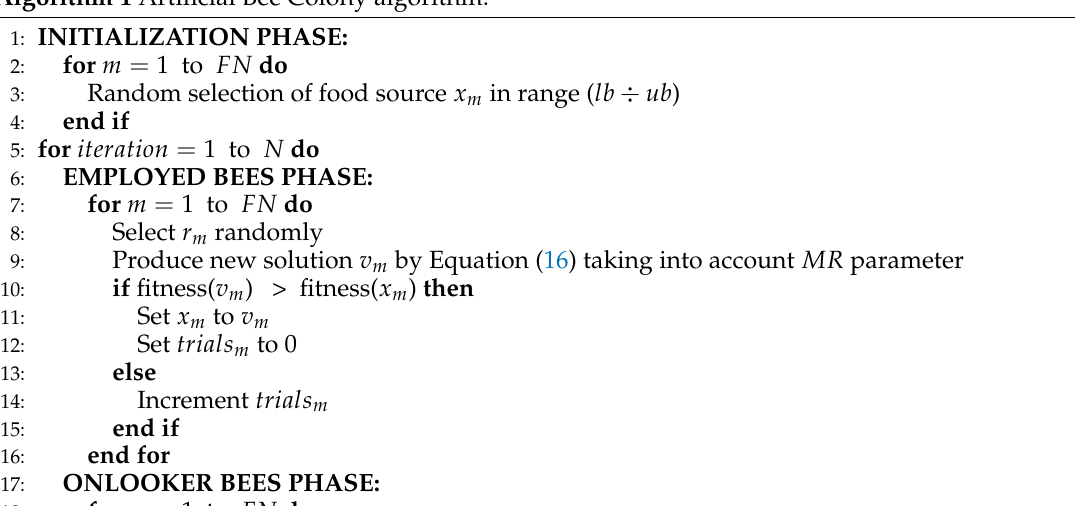
Algorithm 1 Artificial Bee Colony